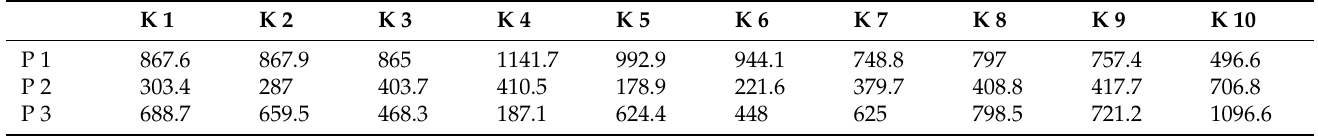
Table A5. Distance between waste treatment center P and sales/collection center K (km).